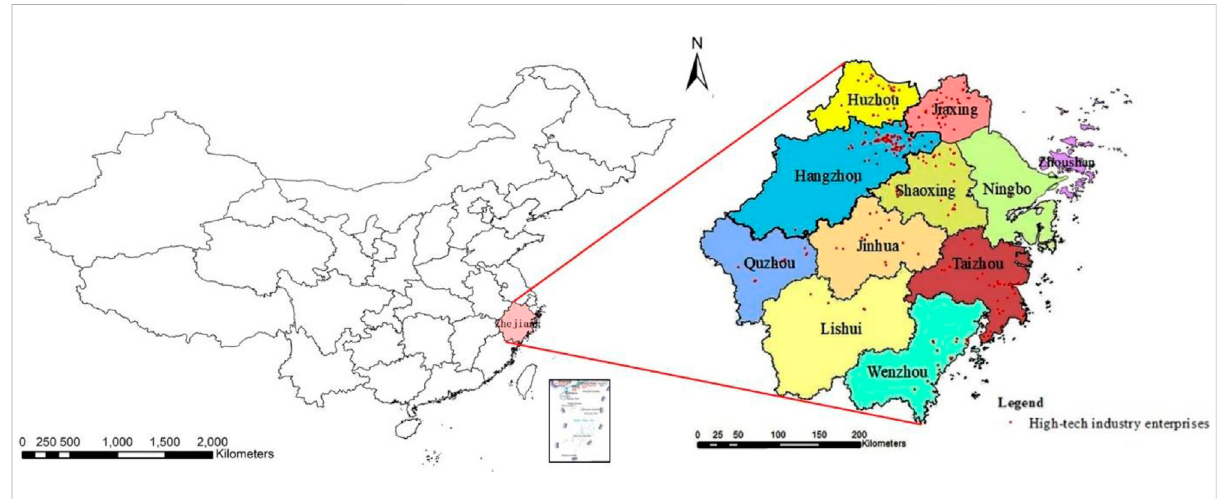
FIGURE 7 Distribution of listed high-tech enterprises in Zhejiang province.